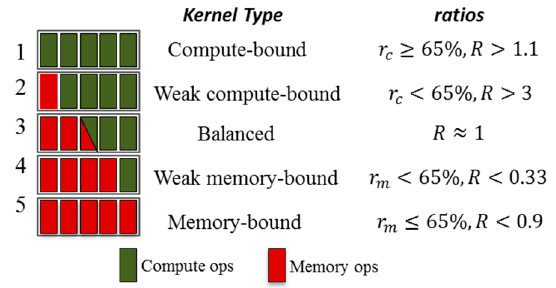
Figure 6. Kernel type categorization based on the resource utilization ratios. The critical values are